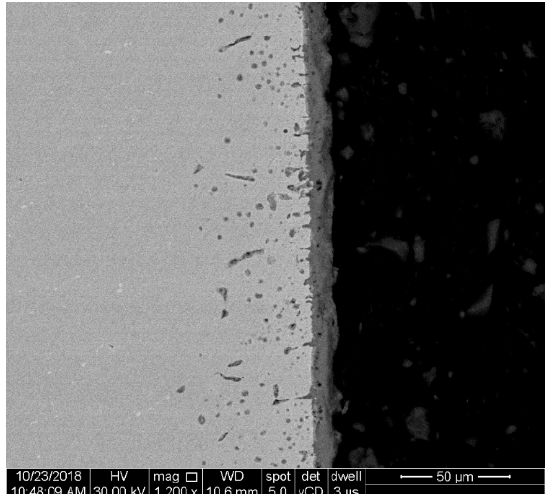
Figure 9. SEM image of a specimen cross-section used for oxide scale thickness measurement.